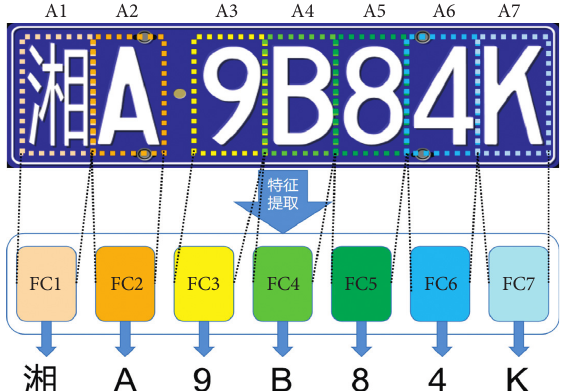
Figure 2: Nonsegmentation license plate recognition